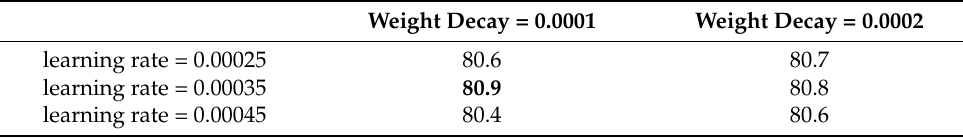
Table 4. Impact of the learning rate and weight decay on the ITOP top-view dataset.